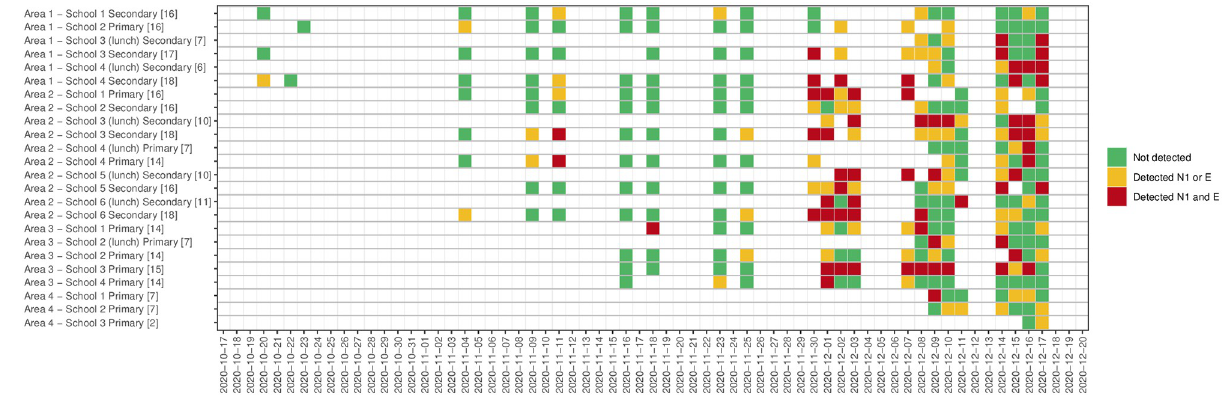
Fig 2. Heatmap detection/non-detection N1 gene and E gene combination. Note: number of samples collected for each school/sample pattern is provided in square brackets at the end of the name of the school.